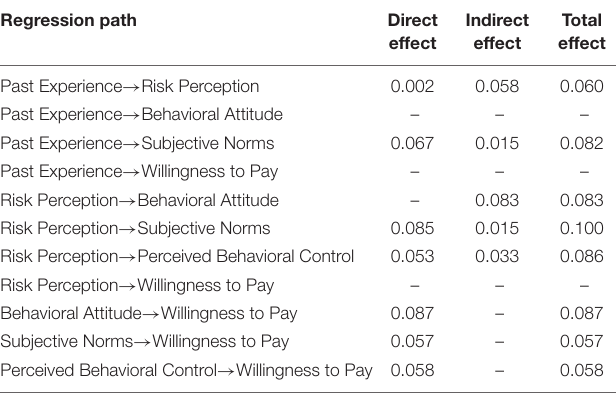
TABLE 8 | Direct effect, indirect effect, and total effect between latent variables and willingness to pay. Regression